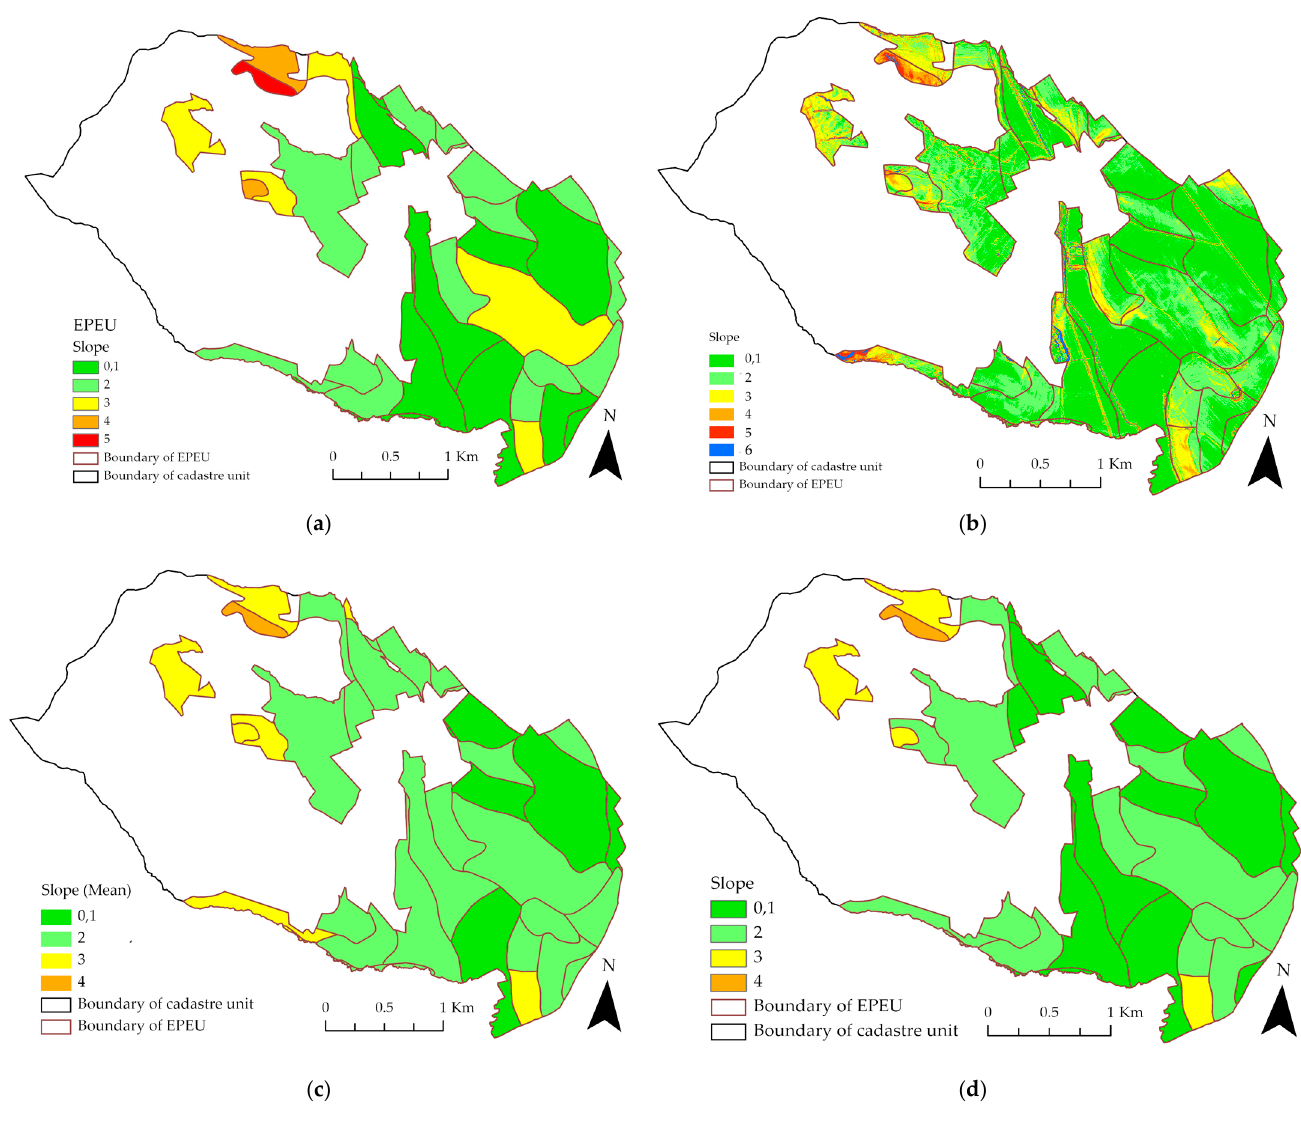
Figure 13. Slope code values assigned based on Table 2 ( a ) by EPEU; ( b ) by DTM 5.0; ( c ) by mean; ( d ) by histogram.